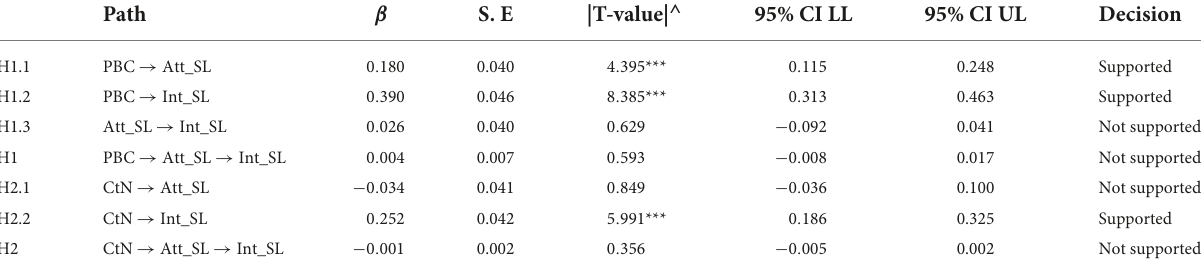
TABLE 3 Results of the structural model.